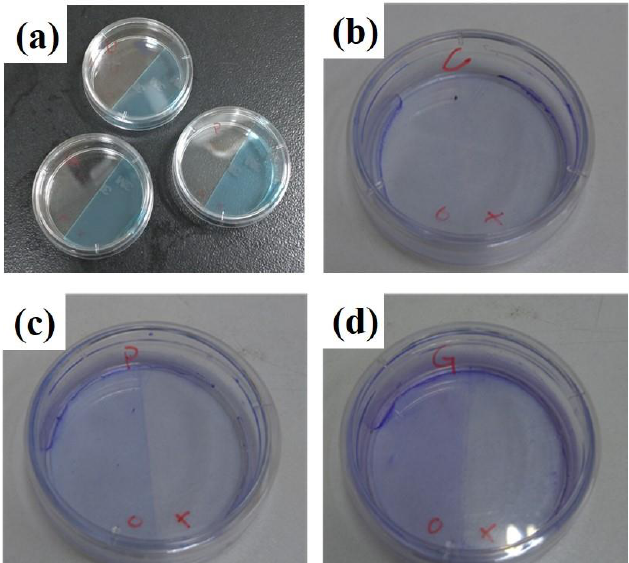
Figure 4. ( a ) Half of the petri dishes were blocked with the tapes. Pictures of Coomassie Brilliant Blue staining of ( b ) phosphate-buffered saline (PBS)-coated (C), ( c ) poly-L-lysine-coated (P), and ( d ) gelatin-coated dishes (G). Circle: coated half. Cross: uncoated half.